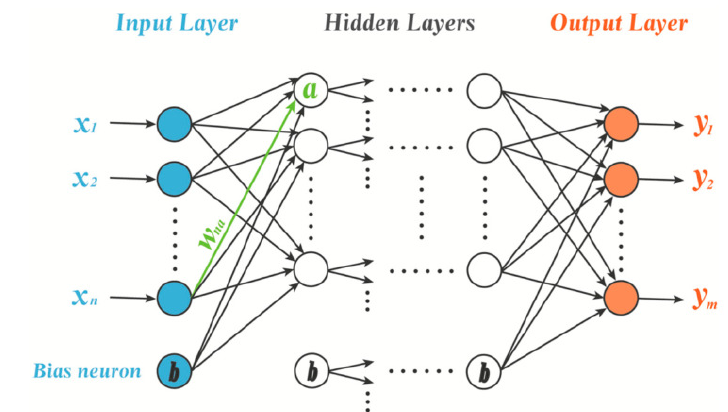
Figure 1. Architecture of multi-layer perceptron (MLP)